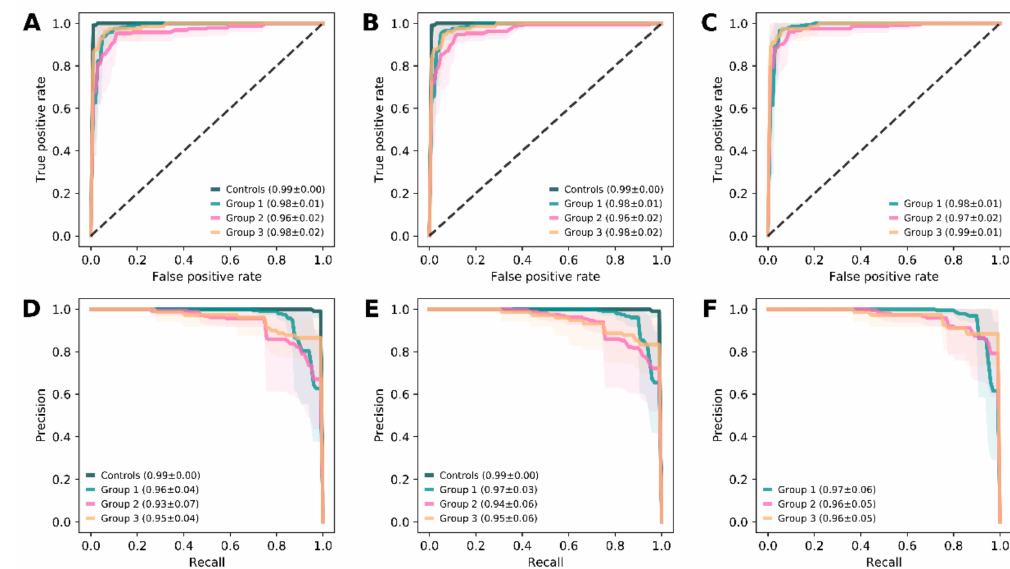
Figure 3. Model performance for the prediction of panretinal function. Receiver operating characteristic (ROC) curves that describe the true positive rate versus the false positive rate (top row, A–C ), and graphs that plot the precision against the recall (bottom row, D–F ) are demonstrated for the models predicting panretinal function based on feature set A (first column, A and D ), B (second column, B and E ), and C (third column, C and F ). The lines represent the mean ( ± standard deviation, shaded area) of all folds for each group category according to full-field electroretinogram results, and the given values are the respective area under the curve (mean ± standard deviation). The plots and respective values demonstrate the high robustness and power of the models to predict the panretinal function. The use of pure retinal thickness data (feature set A , first column) already reached the performance level of the models using additional features (feature set B , second column; feature set C , third